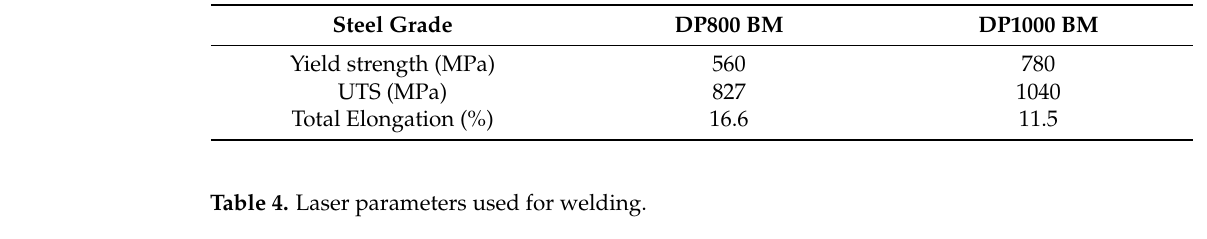
Table 3. Tensile properties of the base metals.